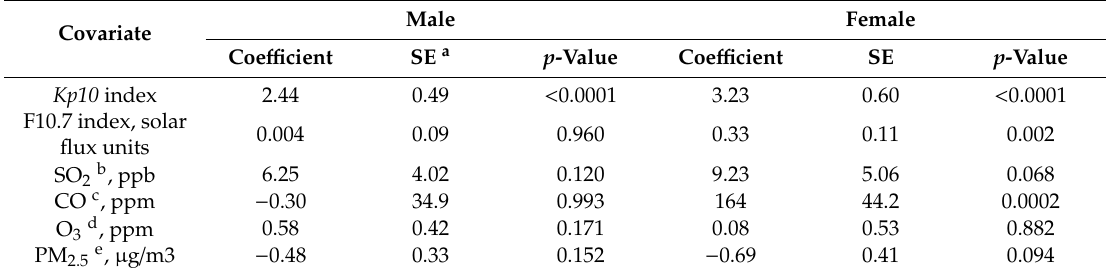
Table 4. Results of the multivariable